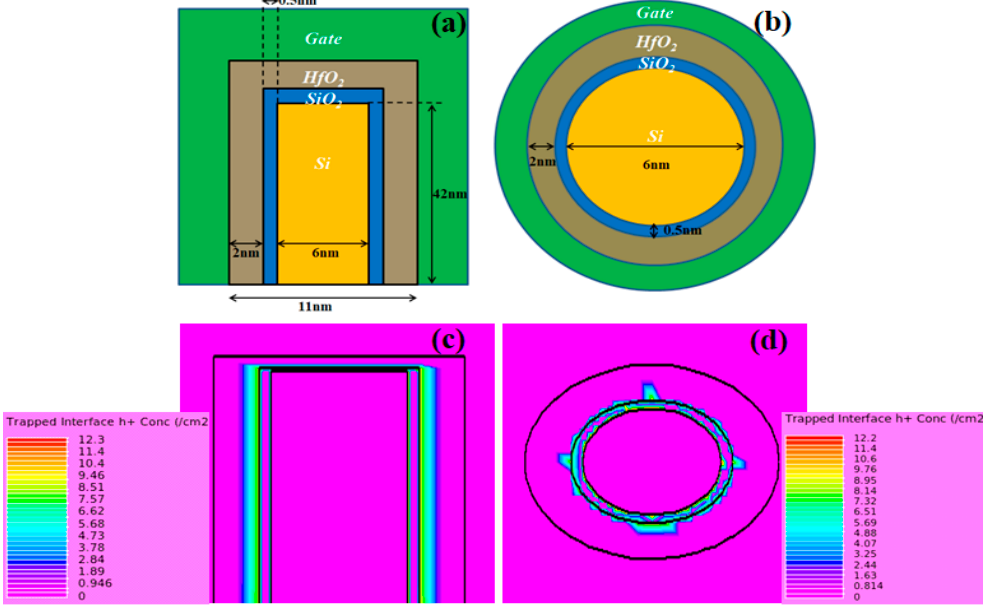
Figure 3. Structure of each device and the interface hole traps after the total ionizing dose (TID) simulation. ( a ) The structure of the FinFET; ( b ) the single-stage structure of 5ch-NW; ( c ) the interface trap of the FinFET; ( d ) the interface trap of the 5ch-NW.